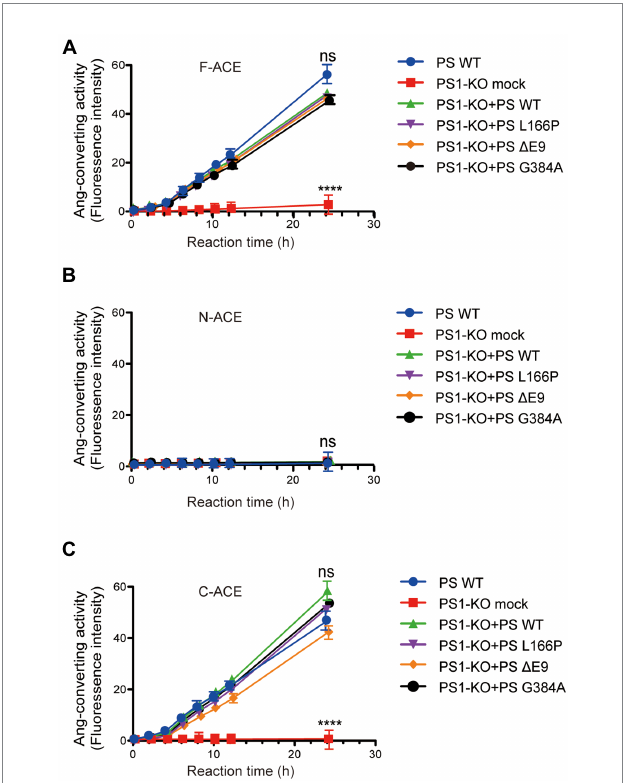
FIGURE 4 Transfection of PS1WT and PS1 mutants restored angiotensin- converting activity of F-ACE and C-ACE in PS1-KO fibroblasts. Ang- converting activity was measured by incubating 2 μ g of ACE protein with the synthetic o-aminobenzoyl peptide substrate for 24 h at 37 ° C. (A) Transfection of PS1WT and PS1 mutants fully restored Ang- converting activity of F-ACE in PS1-KO fibroblasts. (B) N-ACE purified from WT, PS1-KO, and PS1-KO fibroblasts transfected with PS1WT and PS1 mutants did not show any ang-converting activity. (C) Transfection of PS1WT and PS1 mutants fully restored the Ang-converting activity of C-ACE in PS1-KO fibroblasts. PS1WT and PS1 mutants did not exert different effects on angiotensin-converting activity. Values represent the mean ± SD; n = 3; NS, not significant, **** p < 0.0001, Holm-Sidak’s multiple comparisons